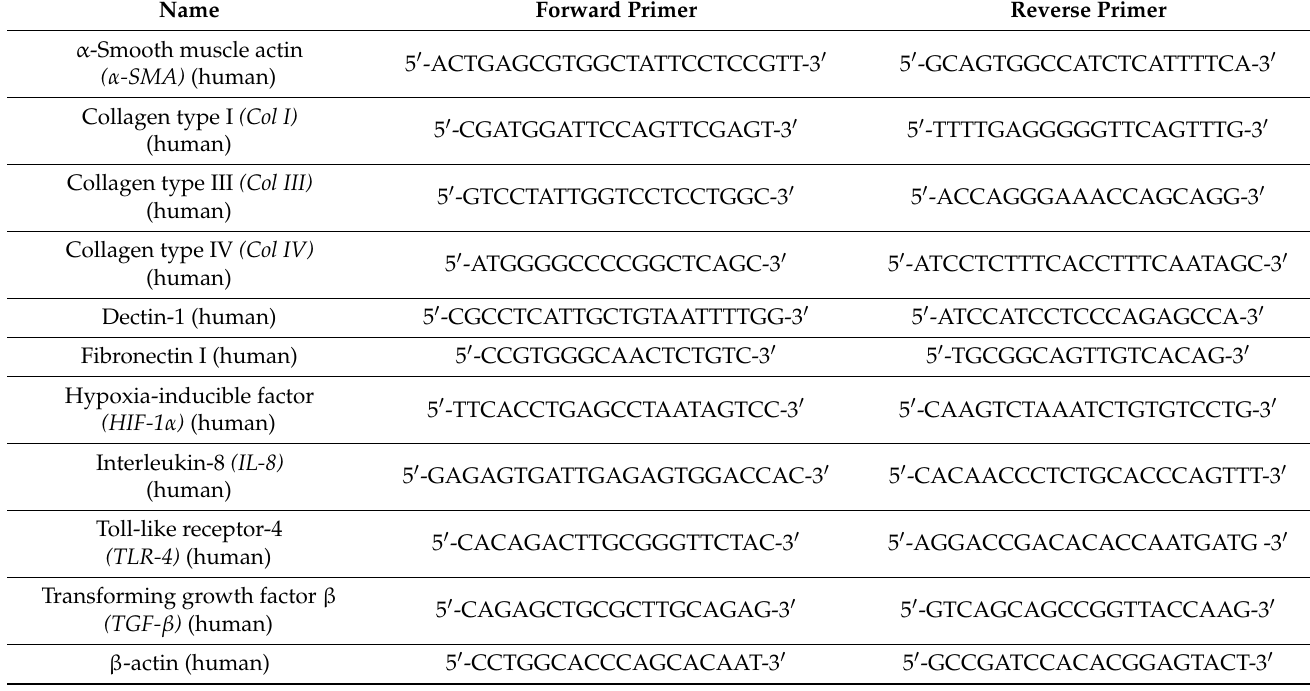
Table 1. List of the